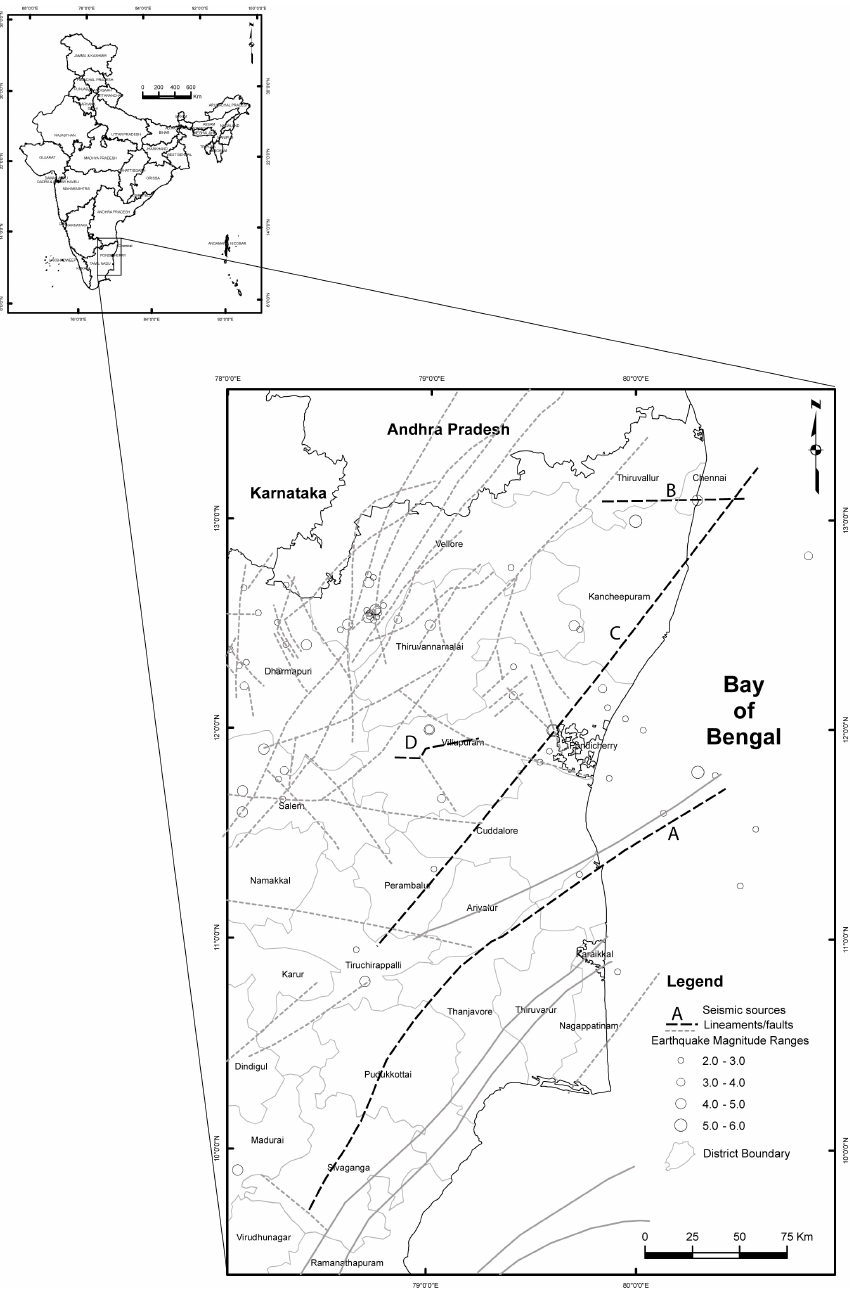
Fig. 1. Seismicity and seismic sources for Chennai